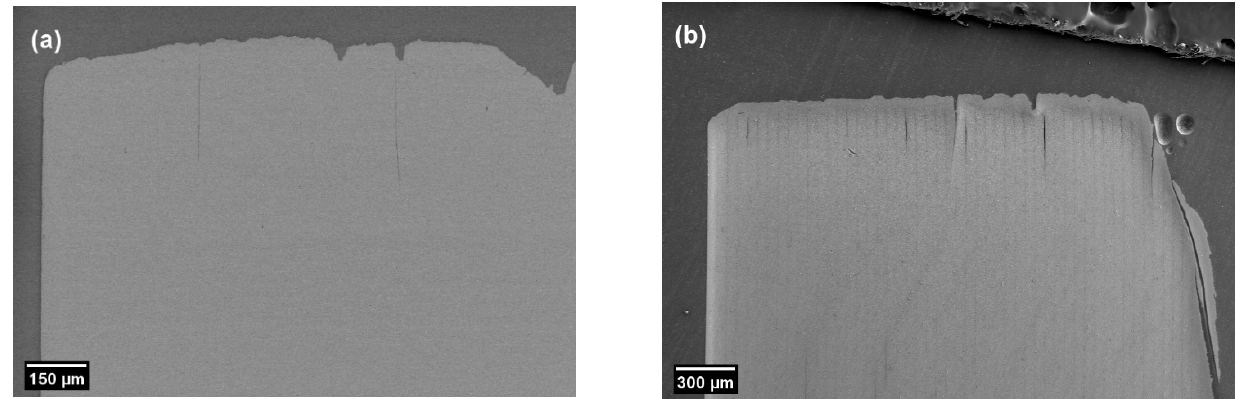
Figure 8. ( a ) Cross-section of sintered specimen at 200 × (back-scattered electron mode) to observe any layer boundaries; ( b ) cross-section of as-printed specimen at 100 × to observe distinctive layer boundaries.